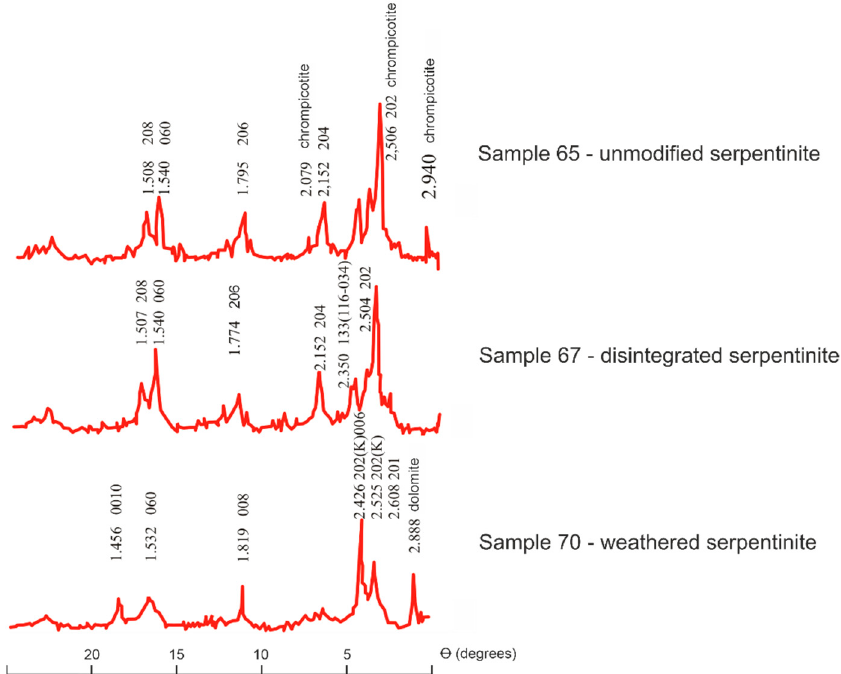
Figure 8. Diffractograms of unmodified, disintegrated, and weathered serpentinites of the Kempirsay massif, Donskoye deposit.